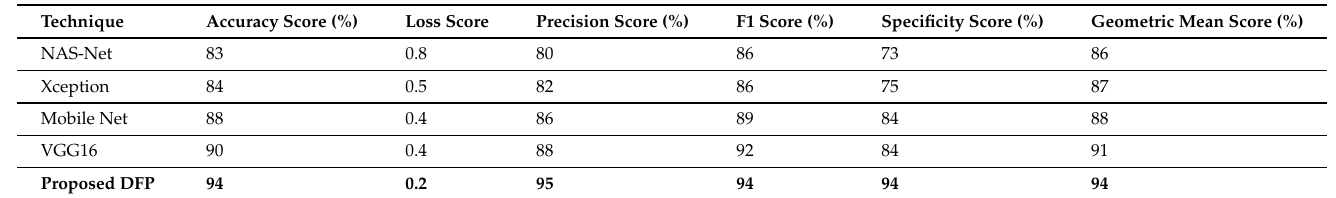
Table 8. The comparative performance analysis of employed neural network techniques on unseen test data.